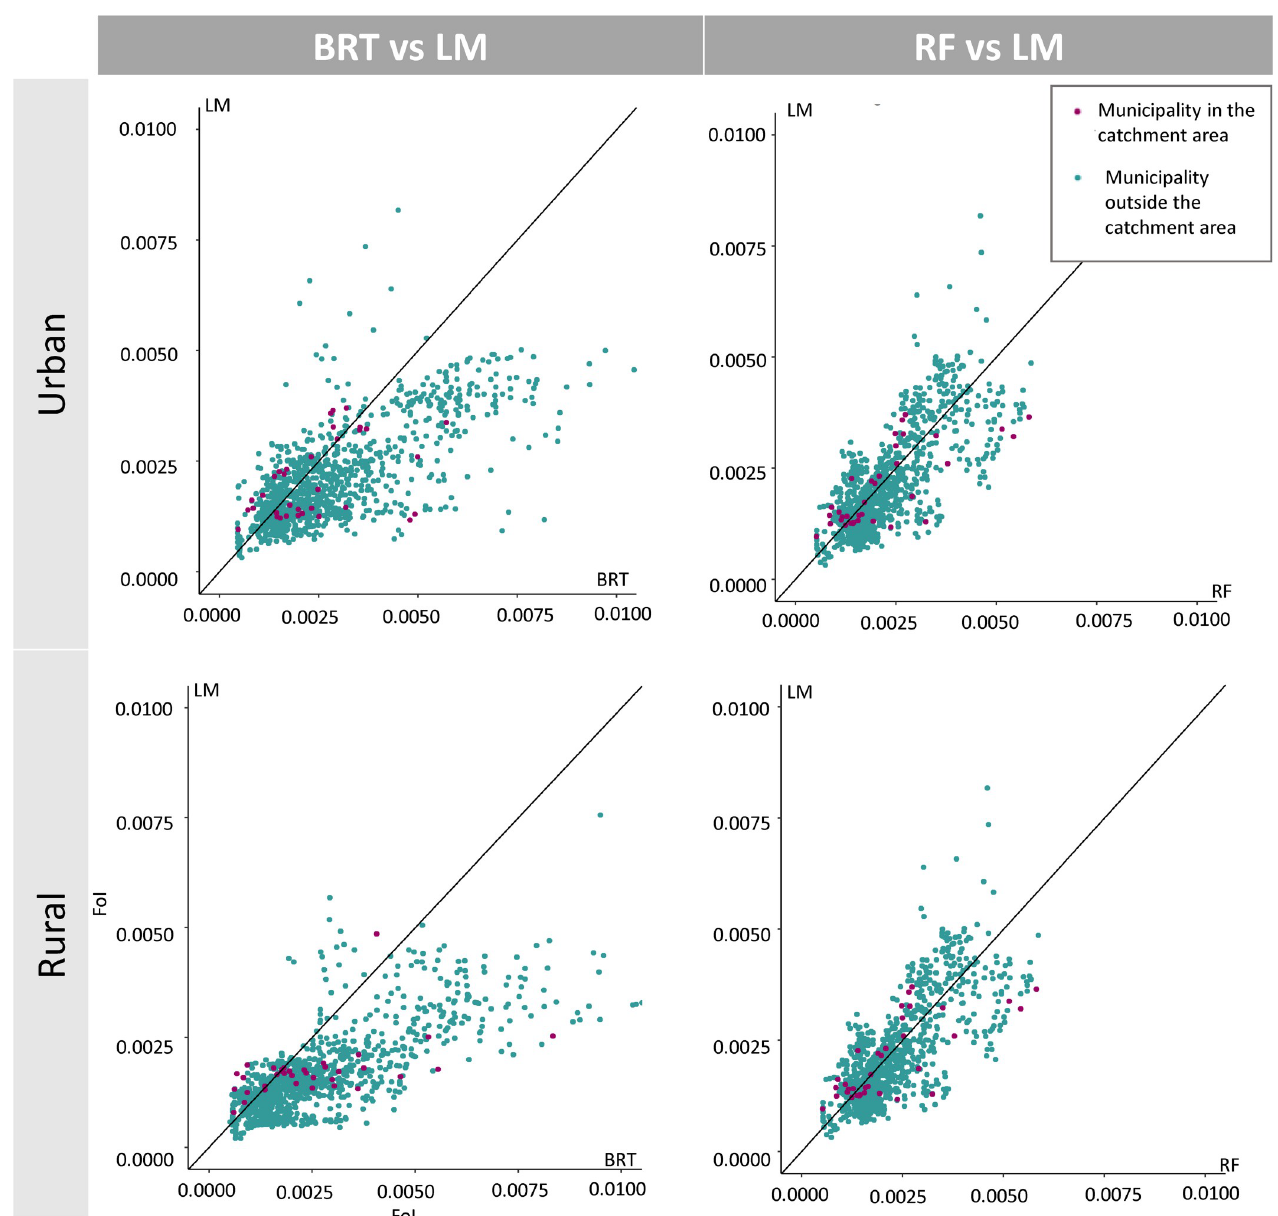
Fig 4. Comparison of predicted Chagas disease Force-of-Infection (FoI) values for urban or rural settings at municipality level, in Colombia for the year 1990. The values were obtained by two Machine Learning (Boosted Regression Trees (BRT) and Random Forest (RF)) methods and a Linear Model (LM) framework using log-transformed FoI estimates from the FullPostFoI approach (see Models’ workflow subsection in Methods and Fig 1 for a description of this approach). The upper panel presents the results for urban settings; the lower panel presents the results for rural settings. Purple-coloured dots denote municipalities where at least one serosurvey had been conducted (‘in catchment area’); teal-coloured dots denote municipalities where no serosurveys had been conducted or were not included in our analyses (‘outside catchment area’). The black solid diagonal line represents perfect agreement between the two frameworks being